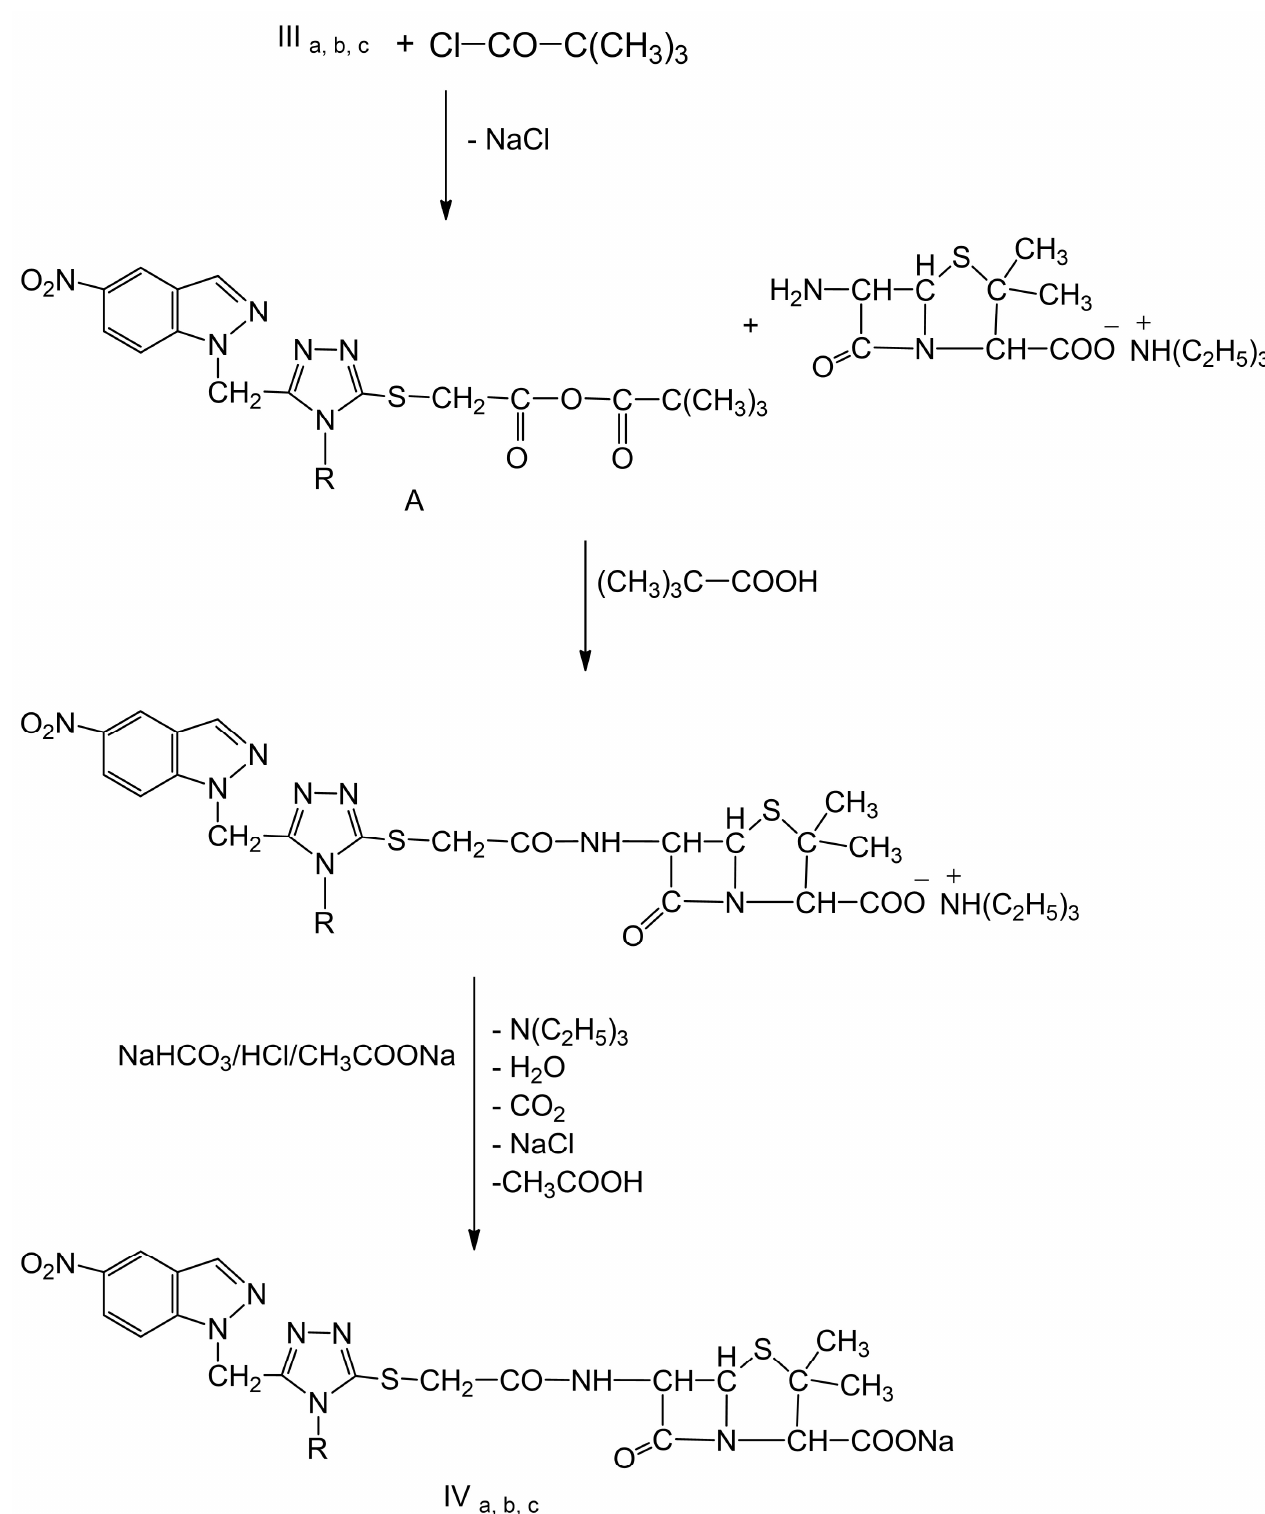
Scheme 4. Obtaining and isolating the 3-[(5′-nitro-1H-indazol-1′-yl)-methyl] -N-aryl-1,2,4-triazole- 5-thioacetamido-sodium penicillinate (IVa–IVc). The substituents are: R = –C 6 H 5 for IIIa; IVa, R = – C 6 H 4 –CH 3 (p) for IIIb, IVb; and R = –C 6 H 4 -OCH 3 (p) for IIIc, IVc. The penicillins were purified by dissolving them in distilled water and extracting butyl acetate from acidic penicillin after acidification, followed by the re-precipitation